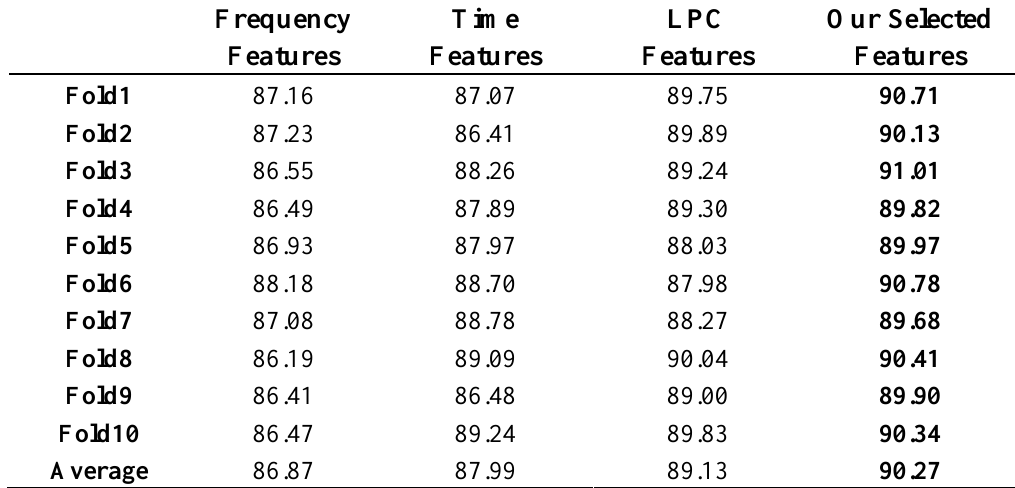
Table 1. Accelerometer classification accuracy with different features.